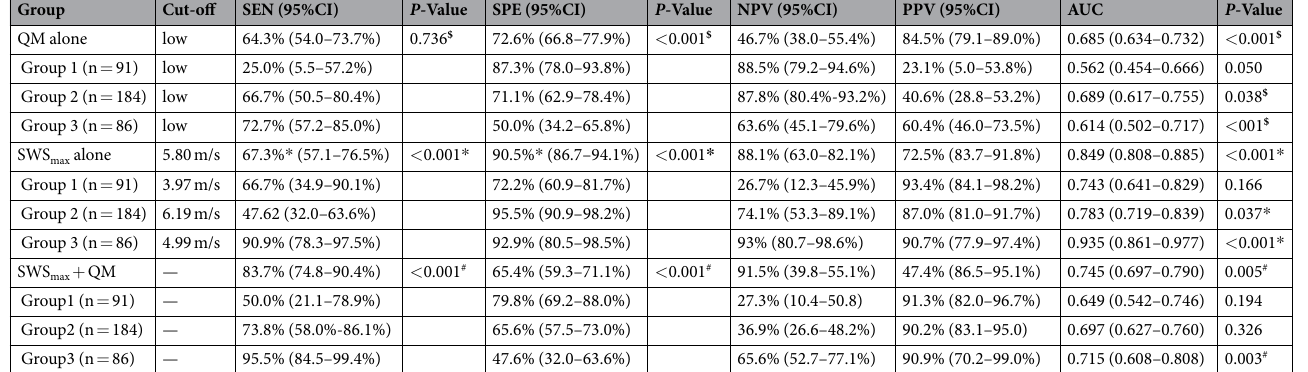
Table 4. The Diagnostic Performances of all the Method. Group1, ≤ 10 mm; Group 2, 11–20 mm; Group 3, > 20 mm. 95%CI = 95% confidence interval. AUC = the area under the curve; QM = quality measurement; SWS max = maximum shear wave speed; NPV = negative predictive value; PPV = positive predictive value. SEN = sensitivity; SPE = specificity; * Indicates a significant difference SWS max vs. SWS max + QM. # Indicate a significant difference QM vs. SWS max + QM. $ Indicate a significant difference QM vs. SWS max